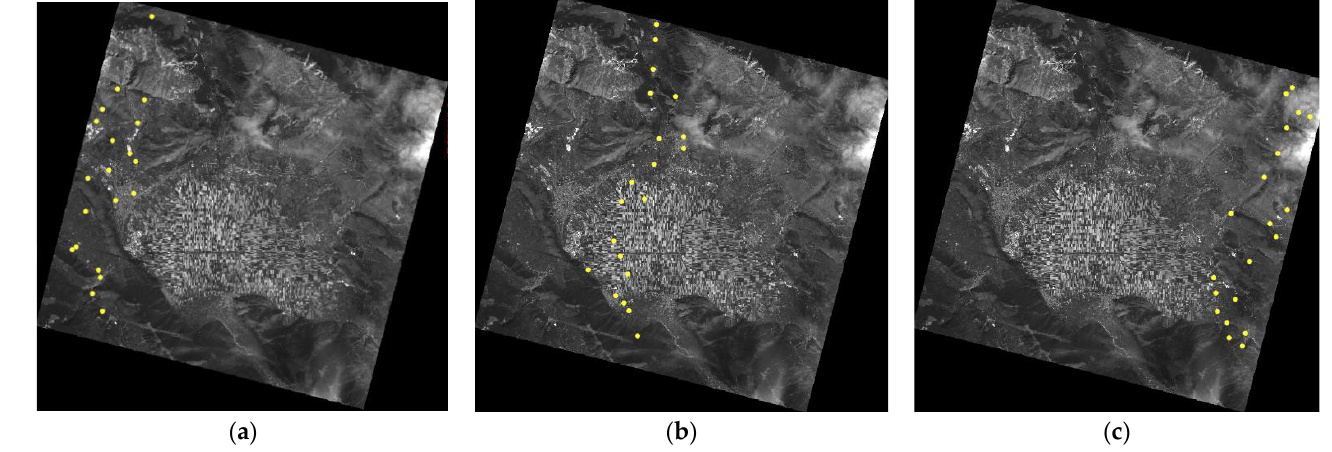
Figure A3. Ground point distribution in N-S direction in the central ( b ) and side areas ( a ) and ( c ) of the image, Fucino test field. Table A5. Results of RPC bundle adjustment with bias compensation for central strip in N-S direction, case (b).